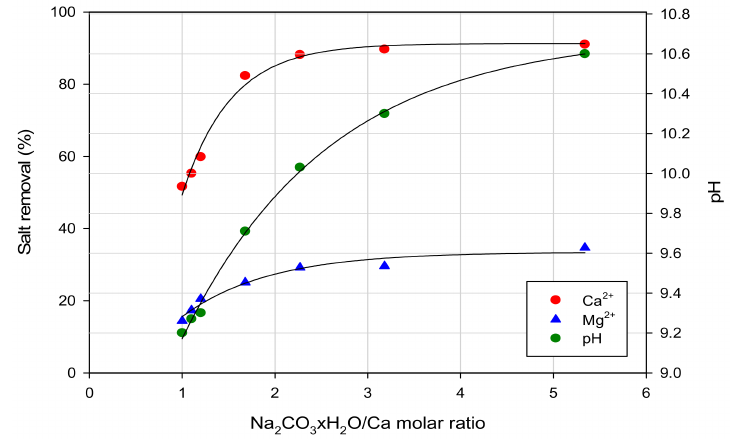
Figure 1. Effect of Na 2 CO 3 · H 2 O/Calcium molar ratio on salt removal and pH.